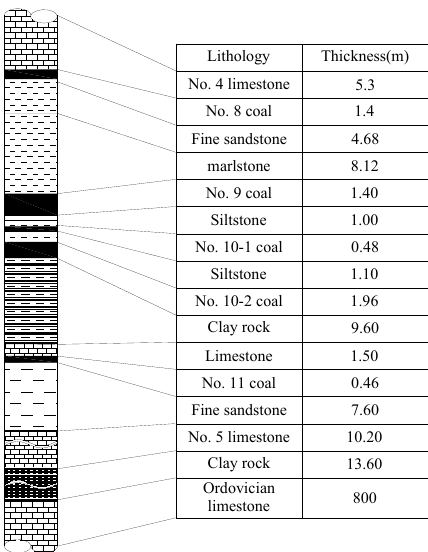
Figure 3. Strata histogram of the mine field.